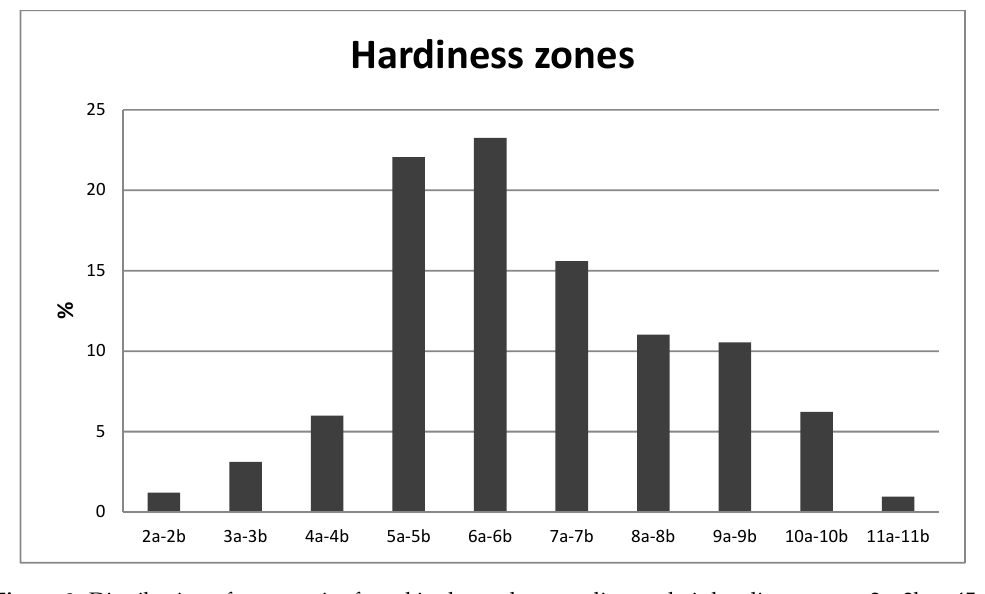
Figure 3. Distribution of tree species found in the parks according to their hardiness zone. 2a–2b: − 45.6 to − 40.0 ◦ C; 3a–3b: − 40.0 to − 34.4 ◦ C; 4a–4b: − 34.4 to − 28.9 ◦ C; 5a–5b: − 28.9 to − 23.3 ◦ C; 6a–6b: − 23.3 to − 17.8 ◦ C; 7a–7b: − 17.8 to − 12.2 ◦ C; 8a–8b: − 12.2 to − 6.7 ◦ C; 9a–9b: − 6.7 to − 1.1 ◦ C; 10a–10b: − 1.1 to